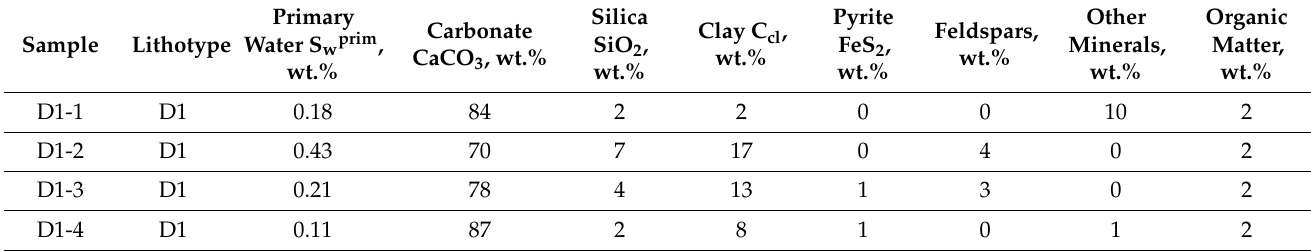
Table 1. Organo-mineral system of the investigated Domanik deposits and primary water content for selected samples.